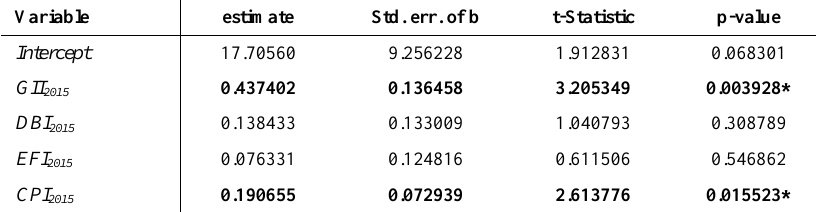
Table 4. The statistical output of the estimated variables for GCI score in 2015